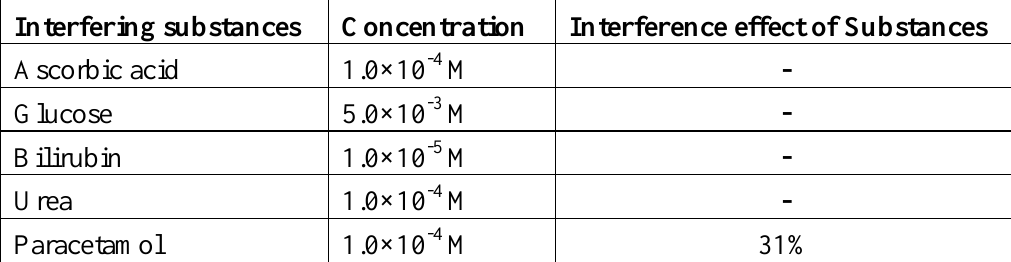
Table 1. Interfering substances (constant uric acid concentration 4.0×10 -5 M) on the amperometric response of the